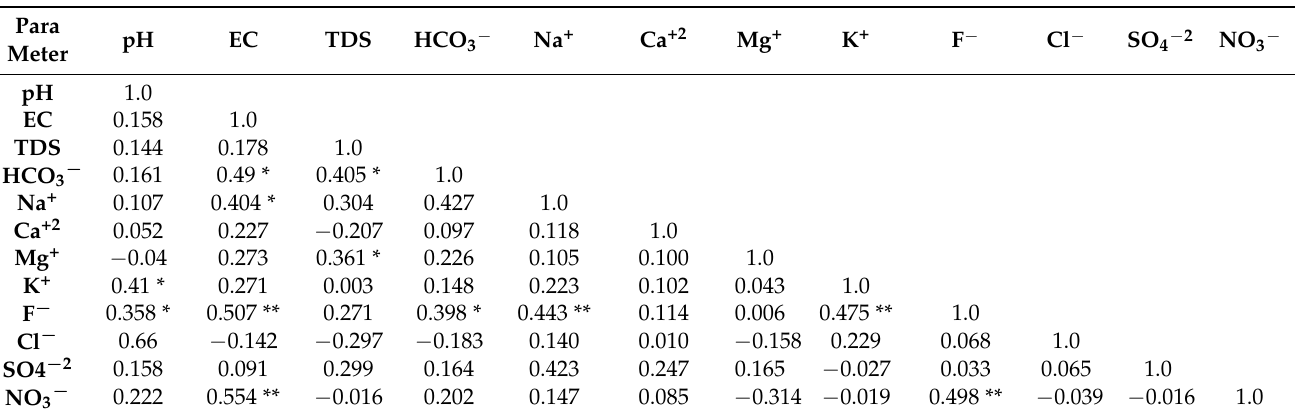
Figure 3. Piper diagram shows different groundwater types, including Na-Cl, Ca-Mg-HCO 3 , Na- HCO 3 , and Ca-Mg-Cl types of coastal water. Mean values of cations and anions are indicated as circles and triangles, respectively, in the four sampling areas of Lasbela (northern region of Arabian Sea, Pakistan). Table 3. Correlation analysis of physicochemical parameters of groundwater samples collected from coastal area of Baluchistan,